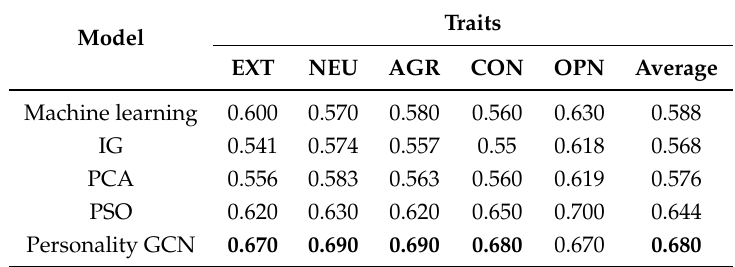
Table 7. Personality GCN classification results of F1-score on the essay dataset.